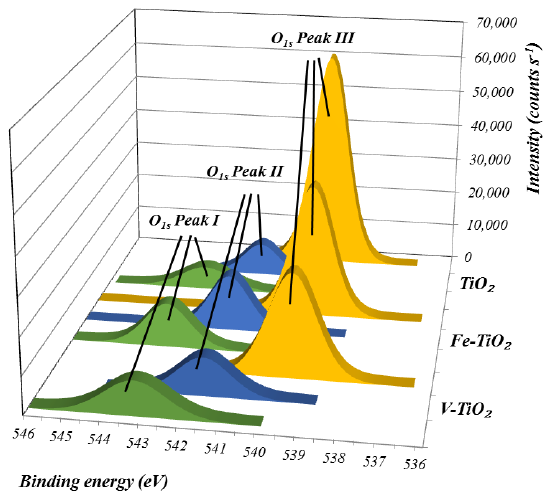
Figure 3. XPS spectra of the O region, showing the three deconvolution peaks of the scans of the assayed photocatalysts. In blue, peak II is related to the adsorption of –OH groups.